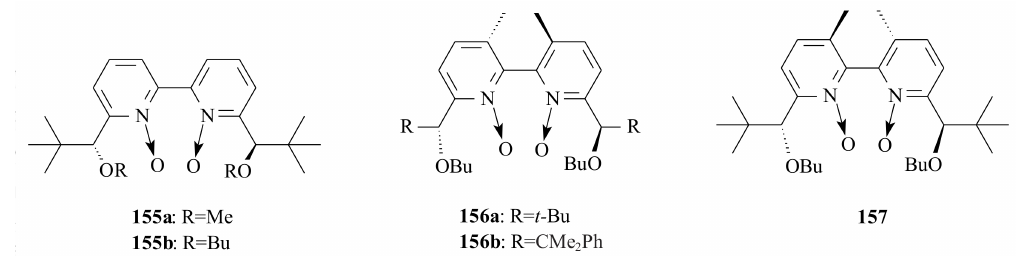
Figure 33. Chiral pyridinyl N -oxide ethers as catalysts in enantioselective aldol additions.